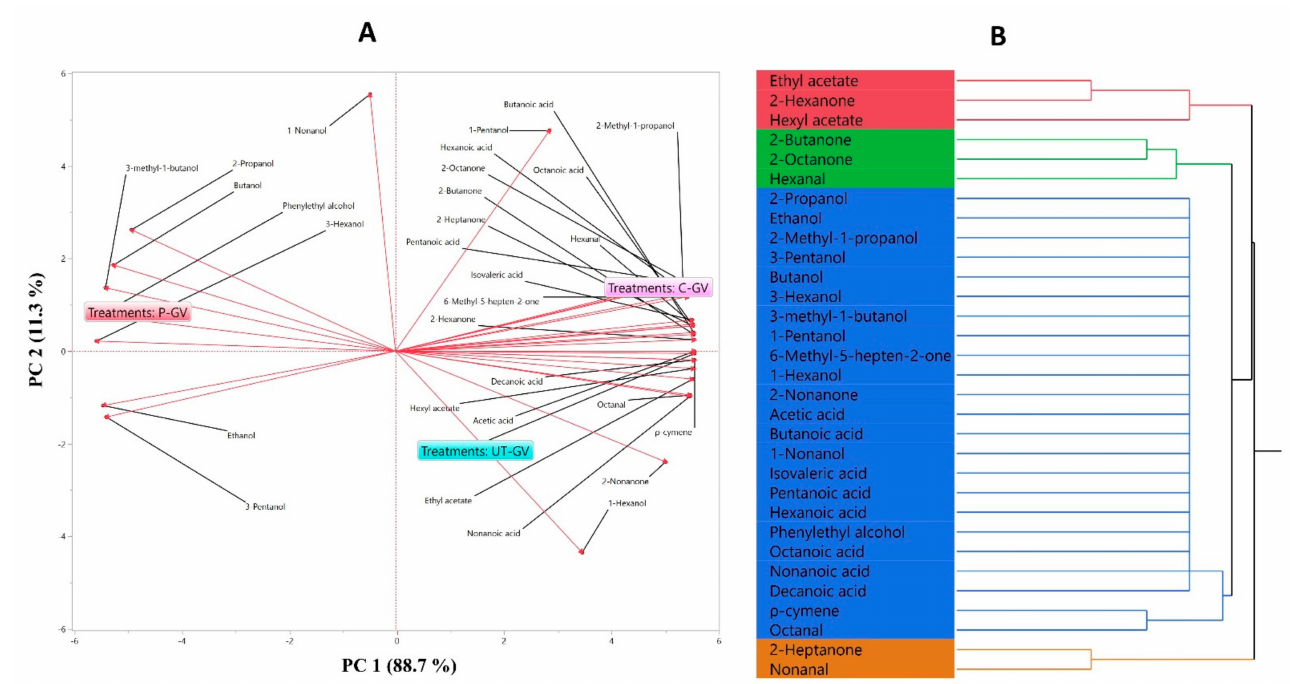
Figure 4. ( A ) PCA bi-plot of volatile compounds in gilaburu vinegar samples. ( B ) Dendrogram of hierarchical cluster analysis of samples and identified volatile compounds. The samples were clustered according to VOCs in the form of red, green, blue, and